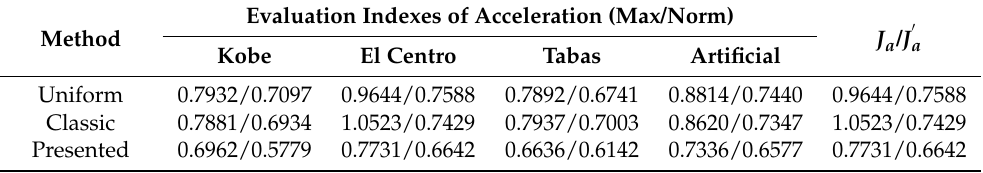
Figure 5. Maximum acceleration of each story with different actuator placements: ( a ) Kobe; ( b ) El-Centro; ( c ) Tabas; ( d ) Artificial seismic wave. Table 6. Evaluation indexes of acceleration under different seismic